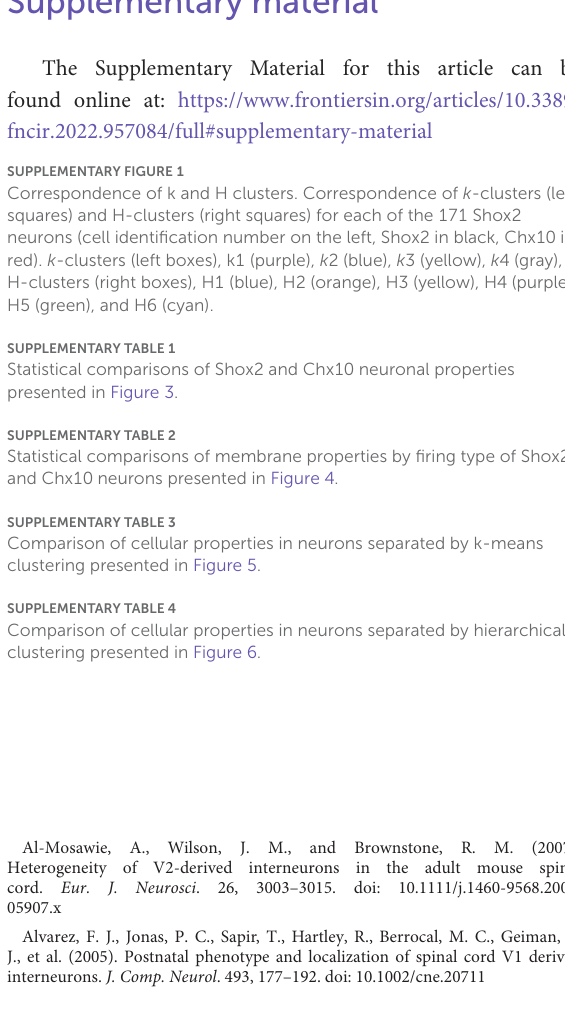
SUPPLEMENTARYTABLE3 Comparison of cellular properties in neurons separated by k-means clustering presented in Figure 5. SUPPLEMENTARYTABLE4 Comparison of cellular properties in neurons separated by hierarchical clustering presented in Figure